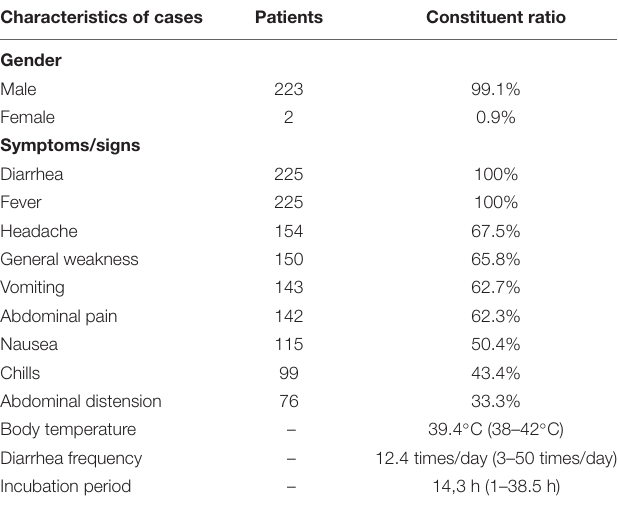
TABLE 1 | Epidemiological characteristics of 225 outbreak